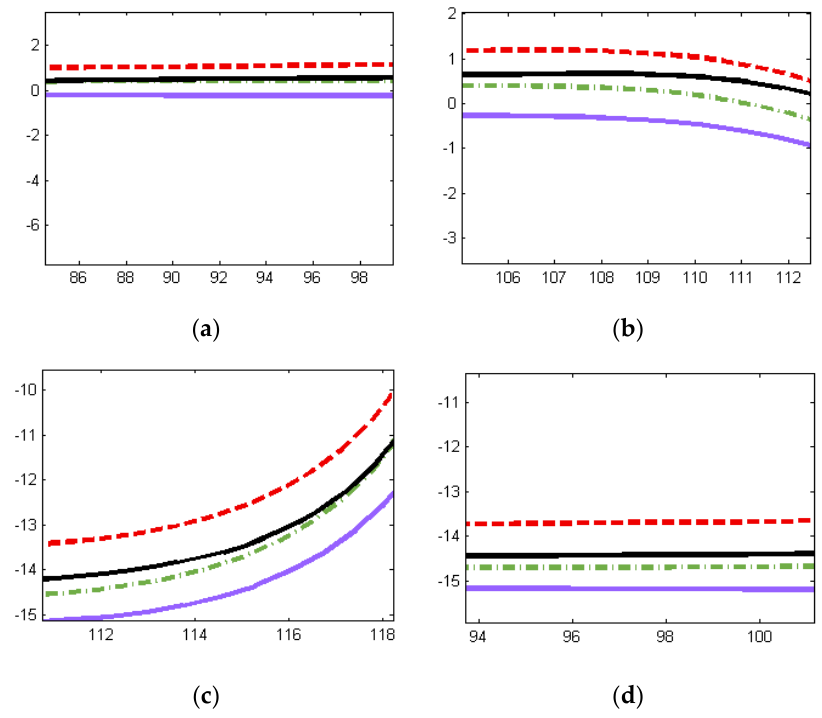
Figure 5. Locally enlarged trajectories. ( a ) In the vicinity of the beginning; ( b ) In the vicinity of the first curved segmentation; ( c ) In the vicinity of the second curved segmentation; ( d ) In the vicinity of the destination.